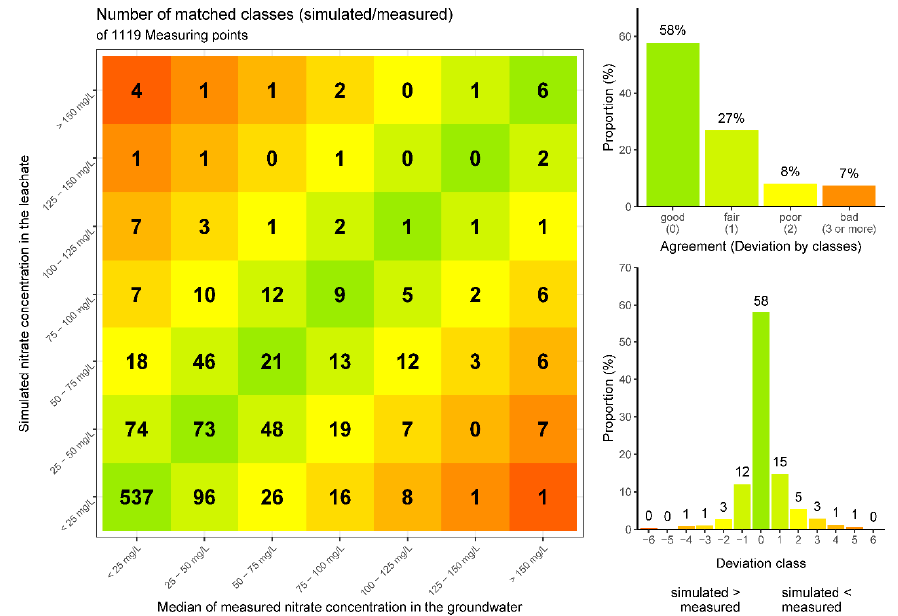
Figure 7. Frequency distribution of simulated nitrate concentrations in the leachate and observed nitrate concentrations in groundwater.